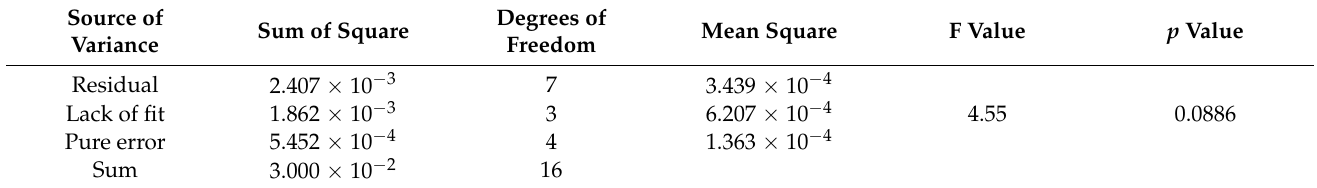
8 of 11 Table 5. Variance analysis of regression model. Source of